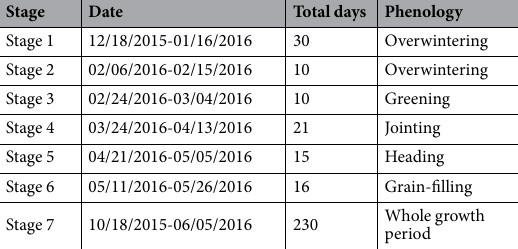
Table 4. Division of stages for winter wheat in the 2015–2016 growing season at the Experimental Station located in Xinxiang, Henan Province,